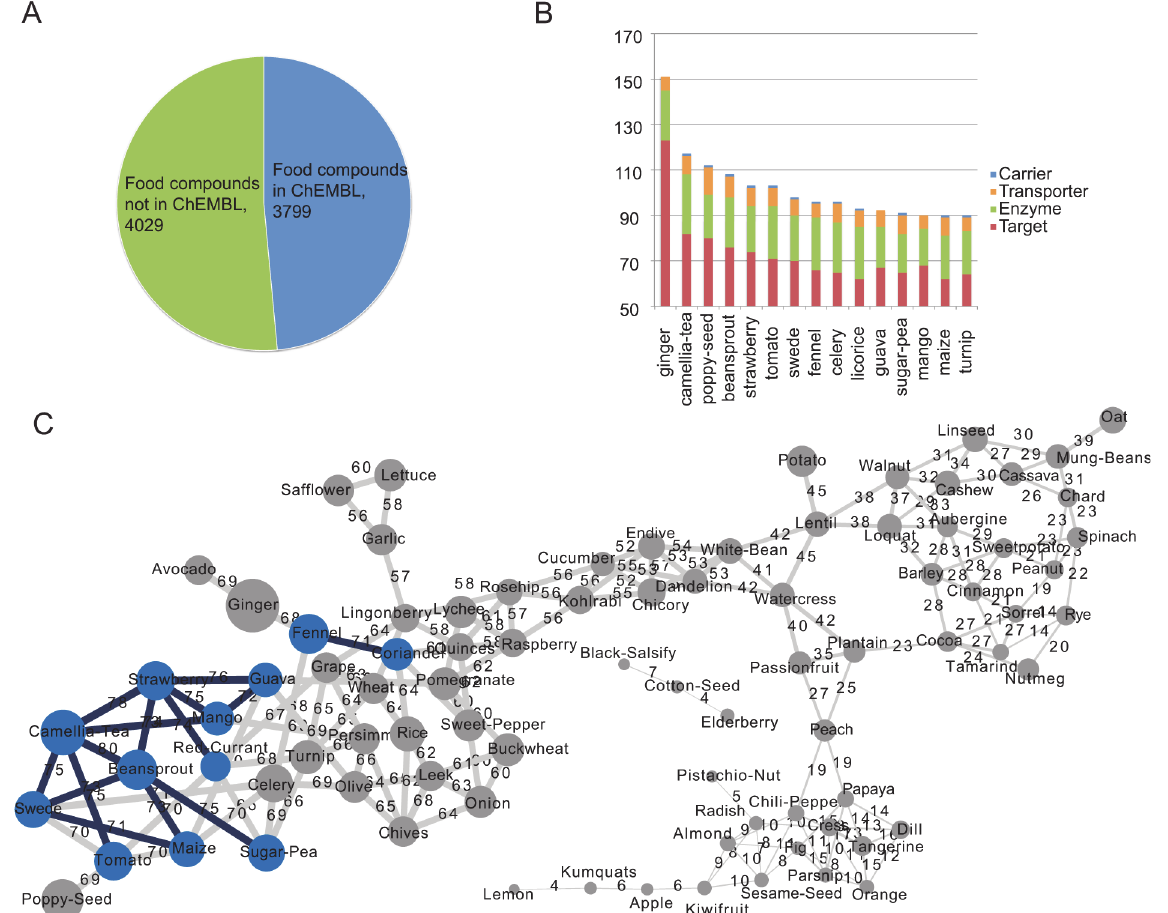
Fig 1. A molecular based view of drug-food interactions. (A) Number of plant-based food compounds in our database with (blue) and without (green) experimental bioactivity information in ChEMBL. (B) The plant-based foods with the most interactions to drug targets, carriers, transporters and enzymes. The plot shows the 15 most interacting foods within these 4 categories. (C) Network of foods that interact with the same drug target proteins. Node size reflects the number of bioactive compounds (phytochemicals) and interacting proteins for a given food. Edge width reflects the number of common interacting proteins between two foods. The nodes with the highest number of bioactive phytochemicals and interacting proteins are shown in blue. The edges with the highest number of common interacting proteins are shown in black. For visualization purposes, the top 5 edges for each node are shown on the network, while the complete data are provided as supplementary material (S1